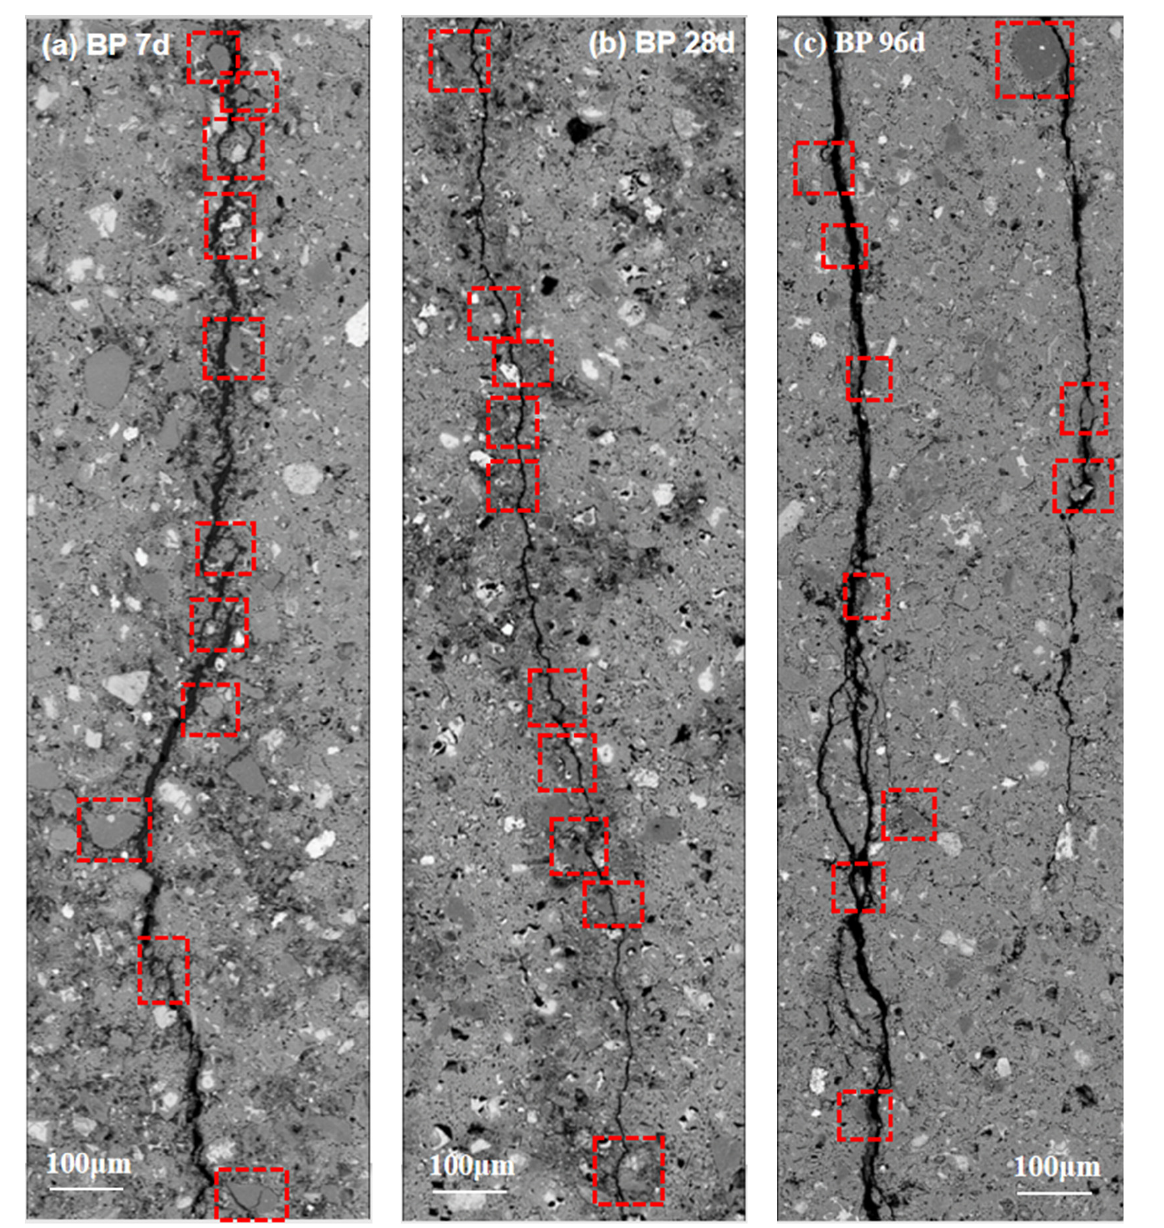
Figure 12. Cracks of hardened BP paste at 7 d ( a ), 28 d ( b ), 96 d ( c ) (The red box indicates the crack developed along the boundary of BP particle).